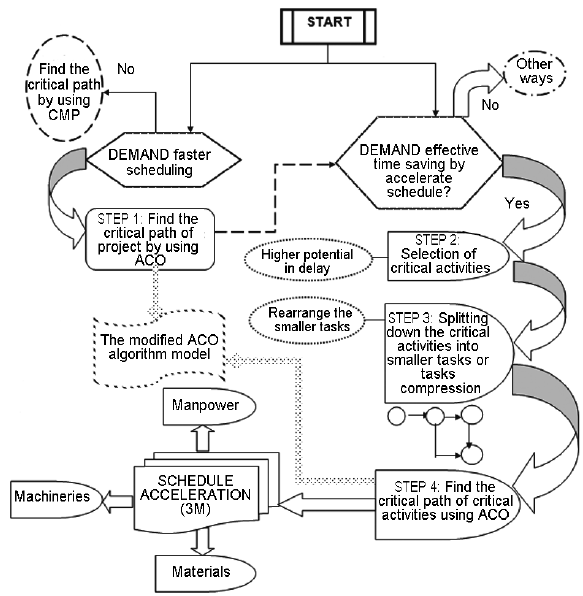
Fig. 2. Appearance of Final CSAM-ACO